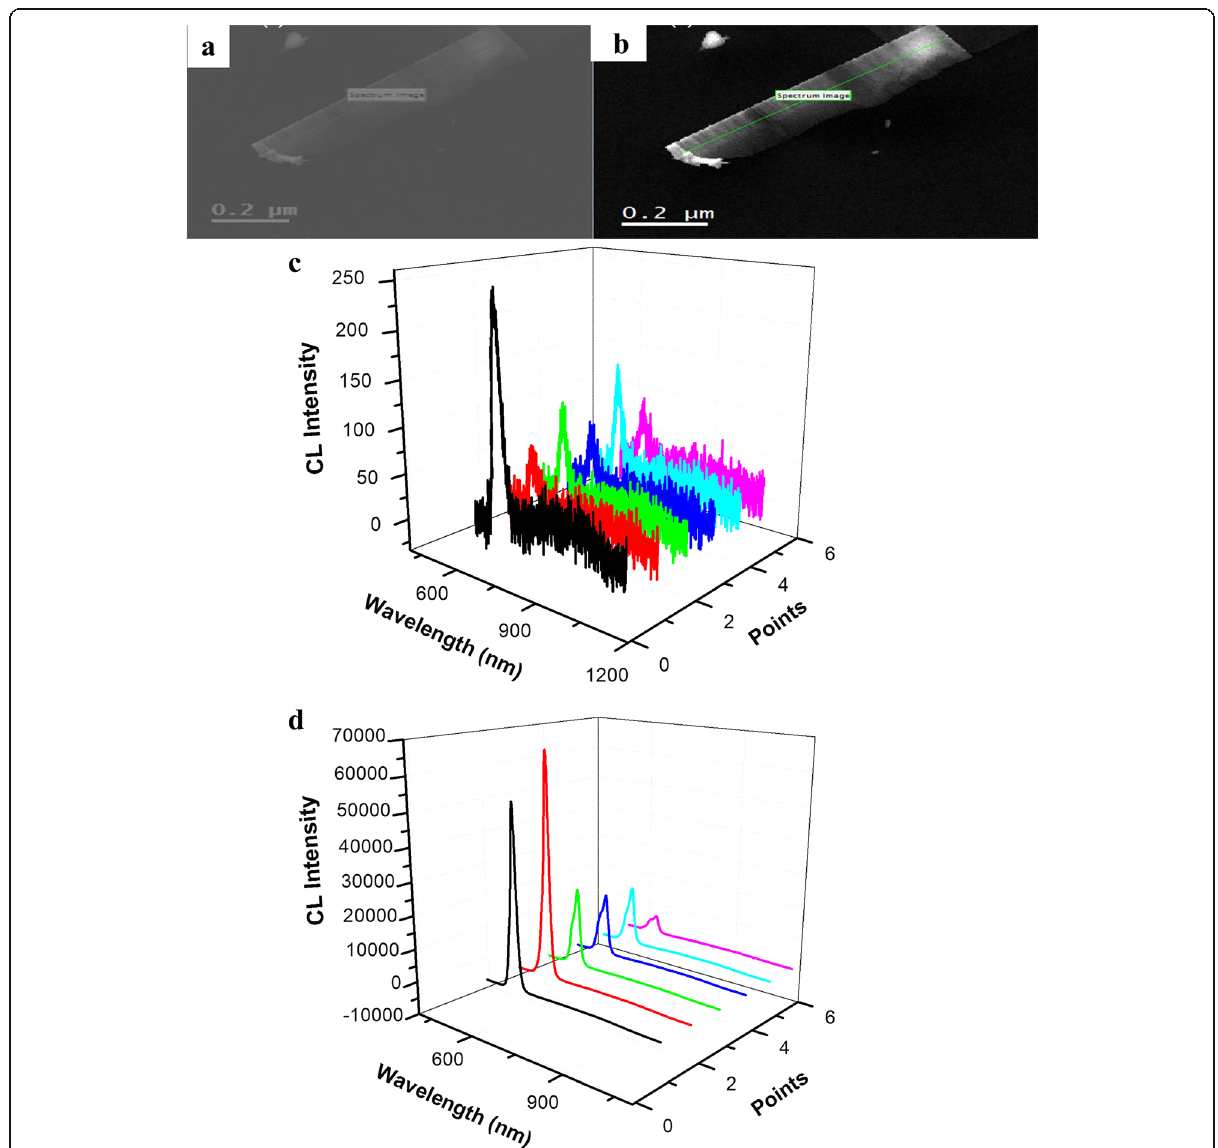
Fig. 6 SEM and CL images of a single CdSSe NB. a SEM. b CL. c CL at 295 K. d CL at 93